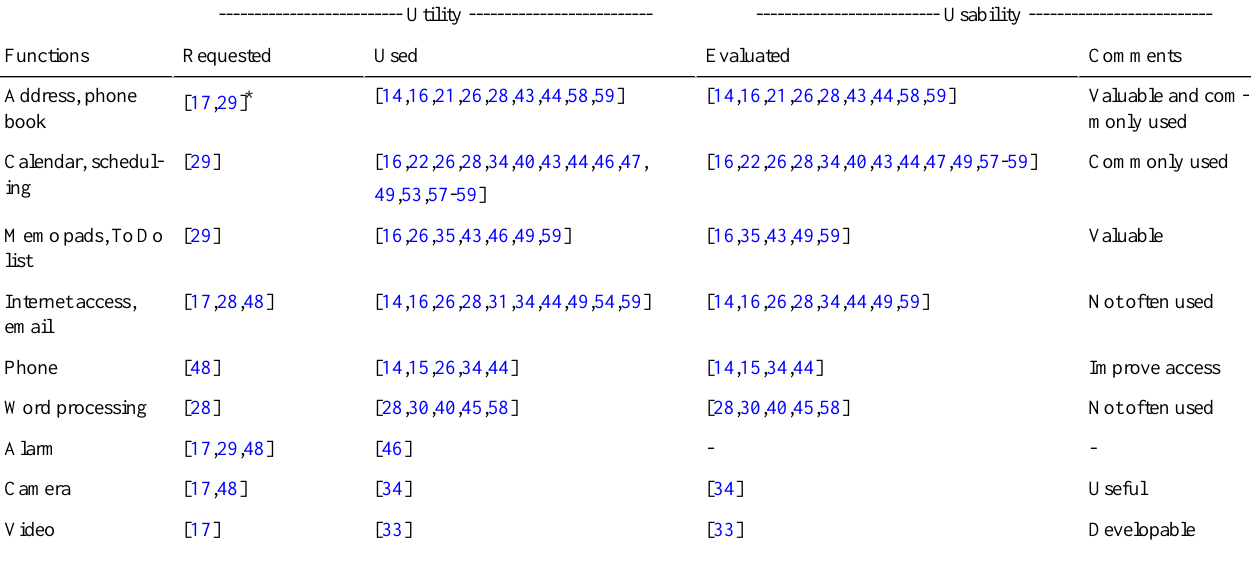
Table 4. Reported usefulness as usability and utility for different functions and features of the PDA